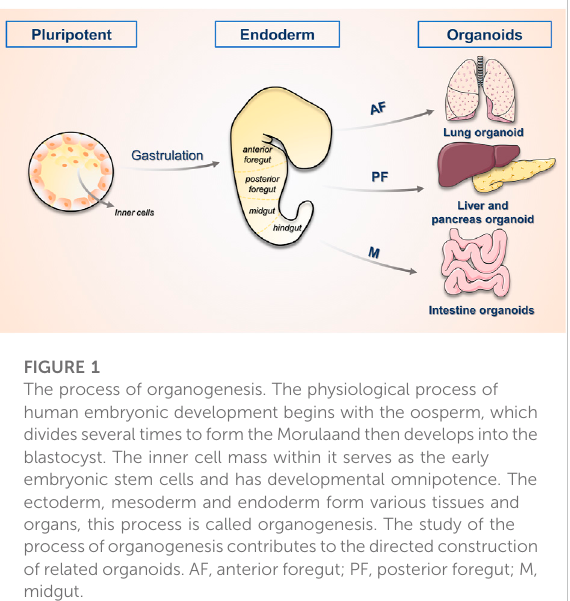
Figure1, theposteriorforegutof theendoderm developsintotheliver asthetriplegermlayerforms.Theliverisformedbythegrowthofthe ventral foregut epithelium, which is fi rst to develop into the hepatic bud structure. The hepatic buds generate hepatocytes and the cholestatic epithelium, while the adjacent mesenchymal stroma of